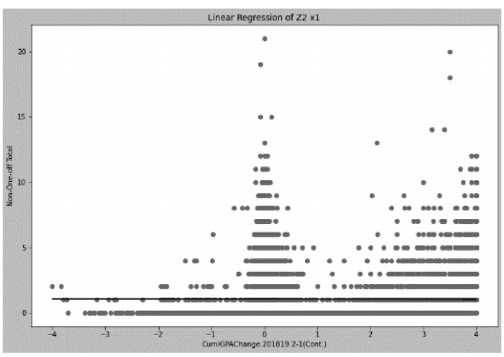
Figure 3. Linear Regression of Z2 x1 in Finding 1